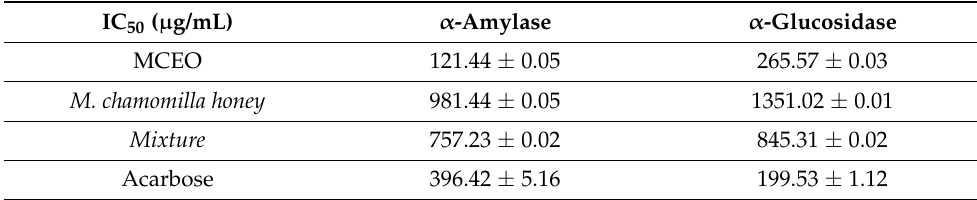
Table 4. Antidiabetic effects of MCEO, M. chamomilla honey, and their